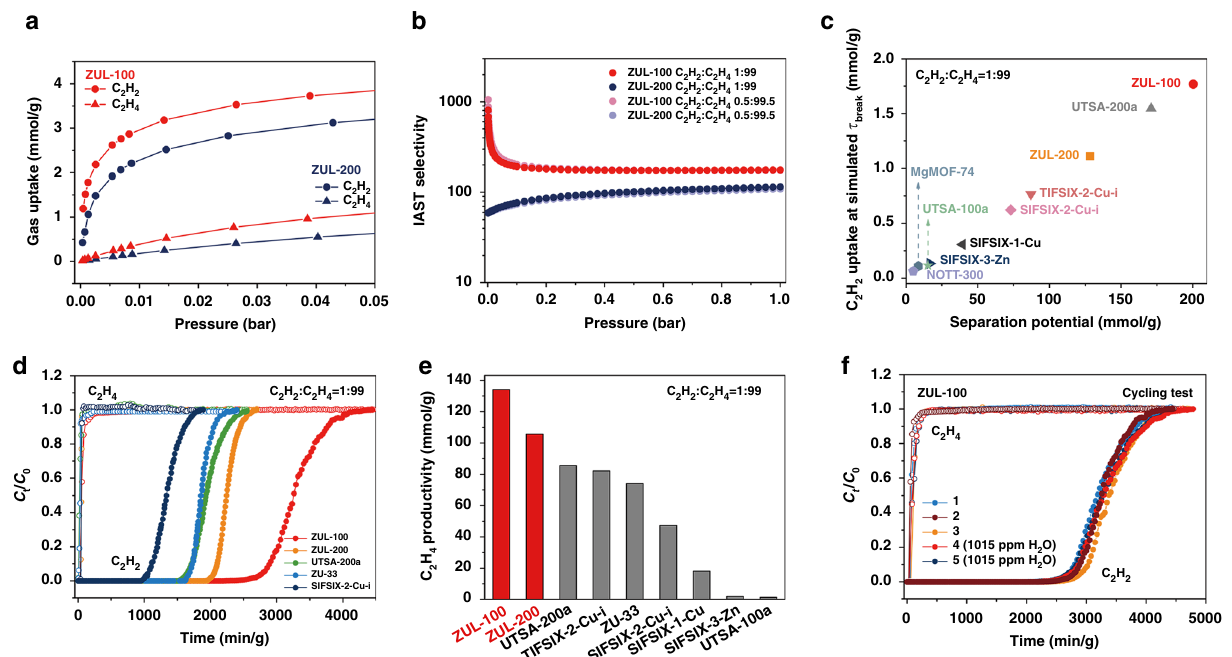
Fig. 5 C 2 H 2 and C 2 H 4 adsorption isotherms, IAST calculations, simulated and experimental column breakthrough results. a C 2 H 2 and C 2 H 4 adsorption isotherms of ZUL-100 and ZUL-200 at 298 K. b The IAST selectivities of ZUL-100 and ZUL-200 for C 2 H 2 /C 2 H 4 mixtures. c Plots of the captured C 2 H 2 amount from the simulated column breakthrough as a function of separation potential from IAST calculations for C 2 H 2 /C 2 H 4 (1/99) separation. d Experimental column breakthrough curves for C 2 H 2 /C 2 H 4 (1/99) mixture with ZUL-100, ZUL-200, UTSA-200a, ZU-33, and SIFSIX-2-Cu-i at 298 K and 1 bar. e Experimental C 2 H 4 productivity (C 2 H 2 below 40 ppm) from C 2 H 2 /C 2 H 4 (1/99) mixture through fi xed bed adsorbers packed with ZUL-100, ZUL- 200 and other materials at 298 K and 1 bar. f The recyclability of ZUL-100 under multiple mixed-gas (including two cycles under moist feed stream) column breakthrough